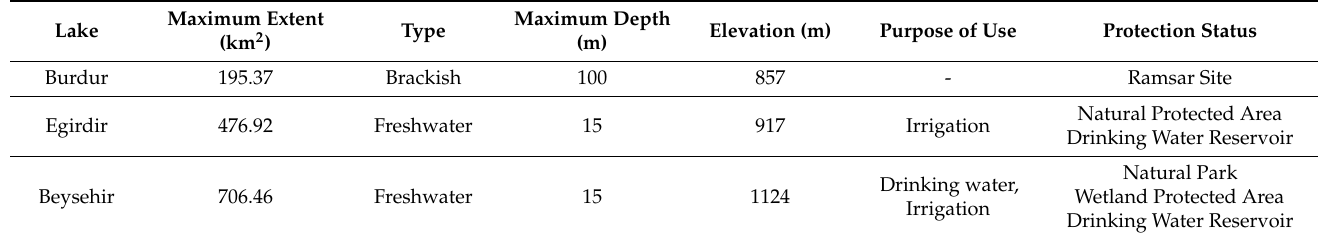
Table 1. Various properties of study lakes [38].